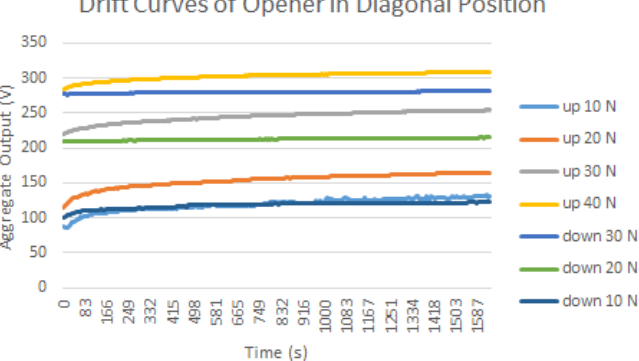
Figure 7. Drift of the Aggregate Output registered by the PCB based sensor and the “opener” object atop for different force increments and